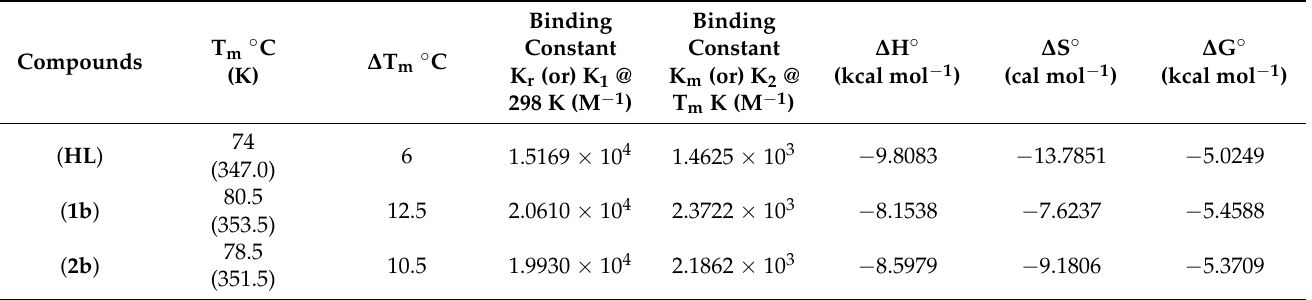
Table 2. The thermodynamic profiles of electronic absorption spectra for the binding of ligand ( HL ) and its complexes ( 1b – 2b ) to